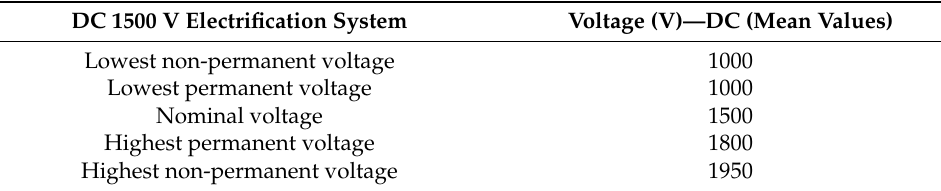
Figure 7. Traction and breaking effort curve under study. Table 3. Supply voltages of DC 1500 V metro traction systems